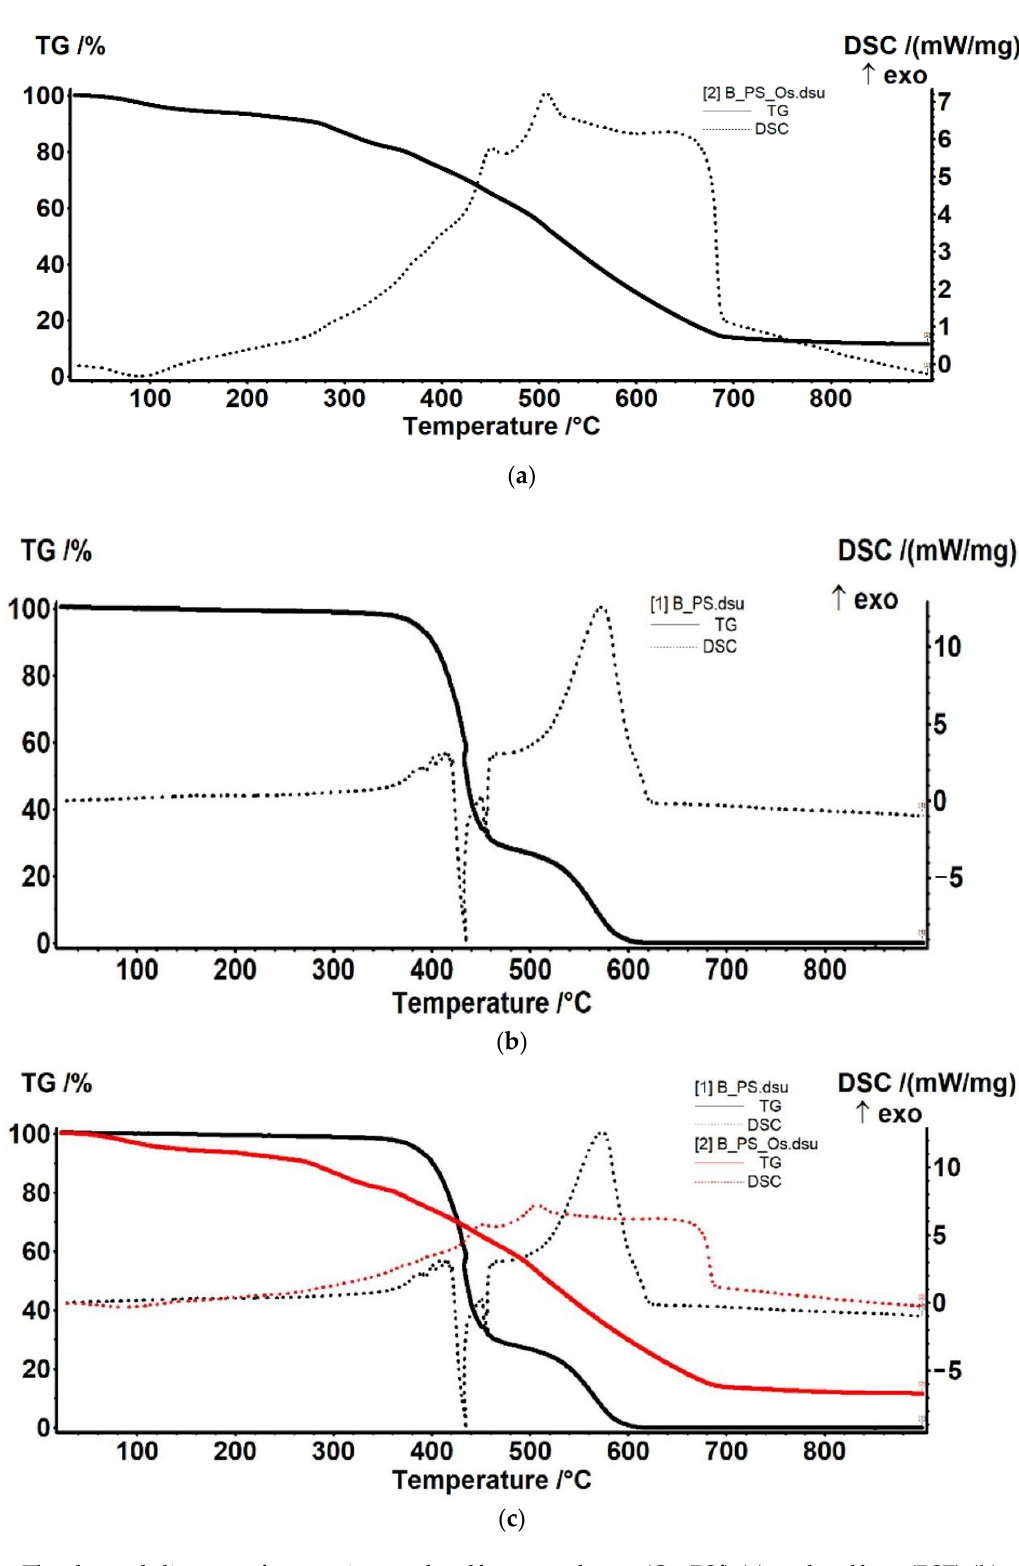
Figure 12. The thermal diagrams for: osmium – polysulfone membrane (Os – PSf) ( a ); polysulfone (PSF) ( b ); and their overlap ( c ).